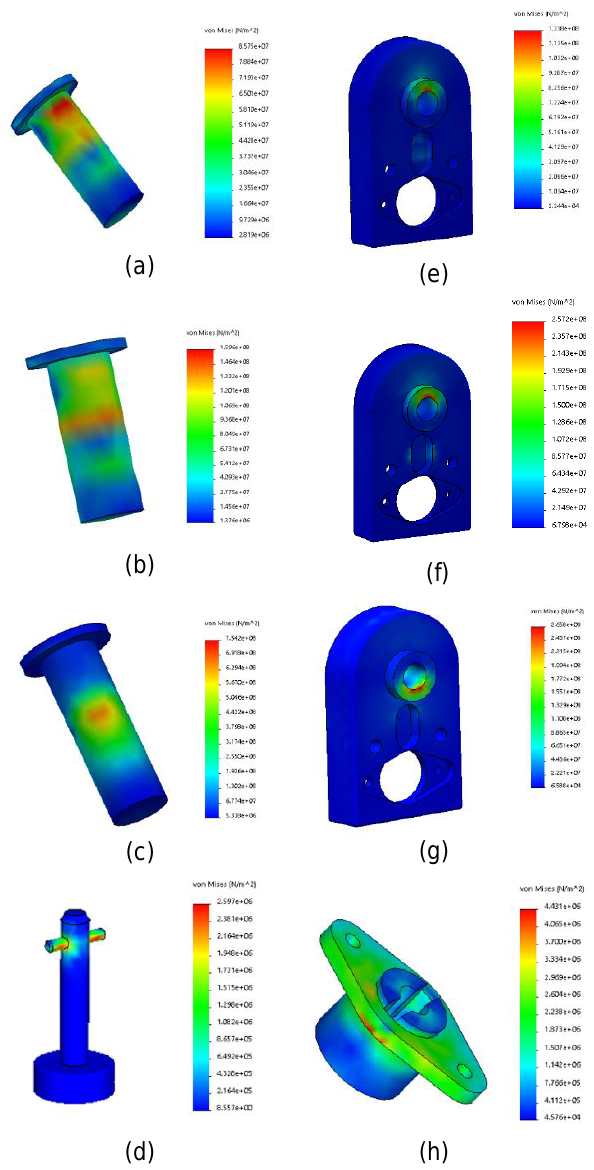
Figure 4: Simulation results for QRM components: stress distributions of weight bearing pin with (a) walking load; (b) running load; (c) downhill walking; (d) stress distribution of quick release key with downhill walking load; (e) stress distributions of anchor with walking load; (f) running load; (g) downhill walking; and (h) stress distribution of receptacle with downhill walking